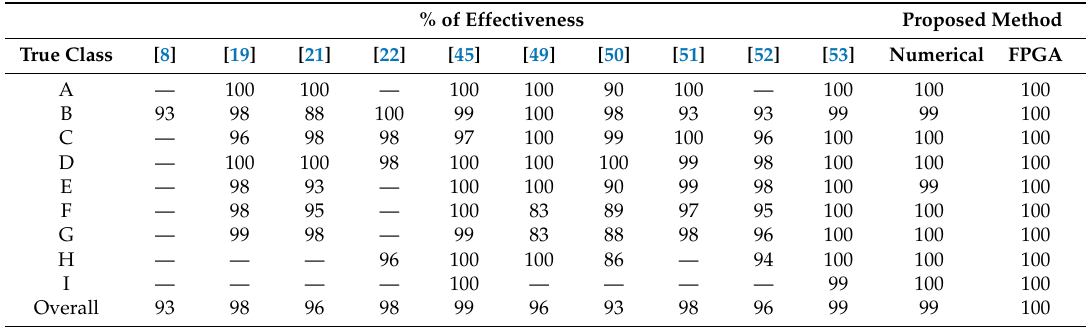
Table 7. Comparative assessment of the proposed FPGA-based methodology and previous approaches.